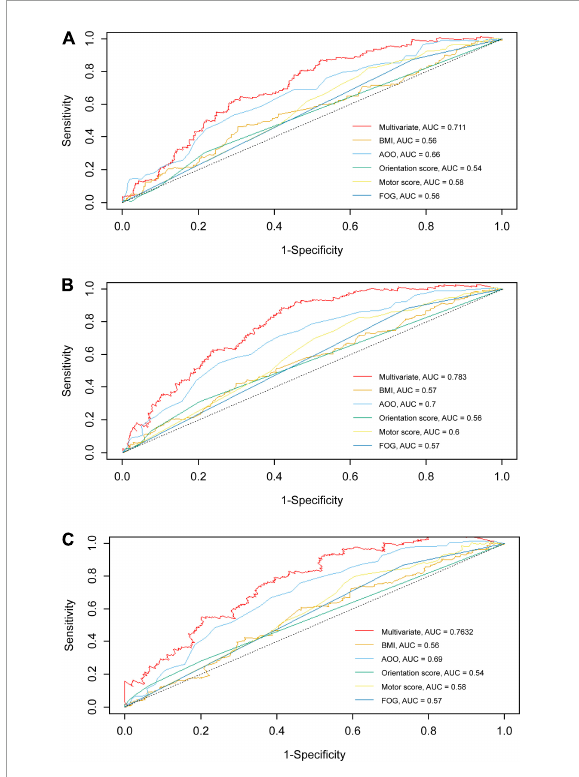
FIGURE4 td-ROC curves of univariate and multivariate at different survival times in the training set. The td-ROC curves shows that the multivariable model has better predictive ability than other single-factor models in training set. (A) td-ROC of 5-year survival; (B) td-ROC of 7-year survival; (C) td-ROC of 10-year survival. td-ROC, time-dependent receiver operating characteristic; AUC, area under curve; BMI, body mass index; AOO, age of onset; FOG, freezing of